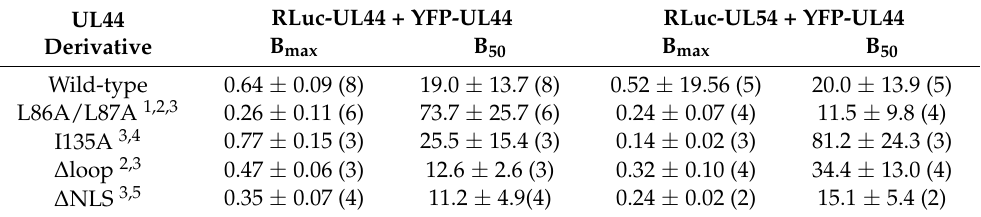
Table 1. BRET saturation curves such as those shown in Figure 4B–F were analyzed to calculate the B max and B 50 values relative to the indicated BRET pairs. Data shown are the mean and stan- dard deviations of the mean. The numbers between brackets indicate the number of independent experiments relative to each BRET pair. 1 Substitutions that impair ppUL44 dimerization and reduce DNA binding in vitro [4]. 2 Substitutions that interfere with ppUL44 DNA binding in cells